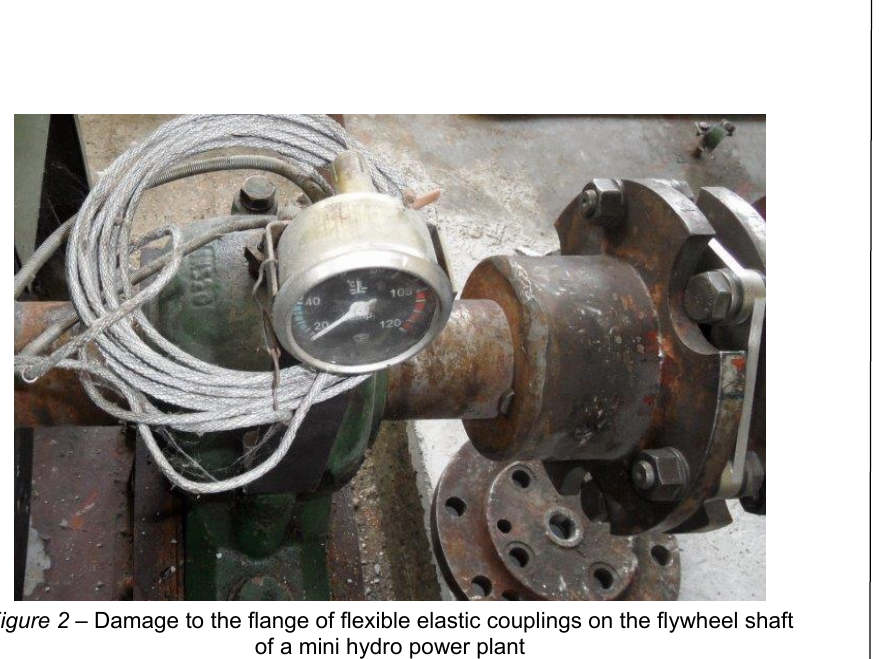
Figure 2 – Damage to the flange of flexible elastic couplings on the flywheel shaft of a mini hydro power plant